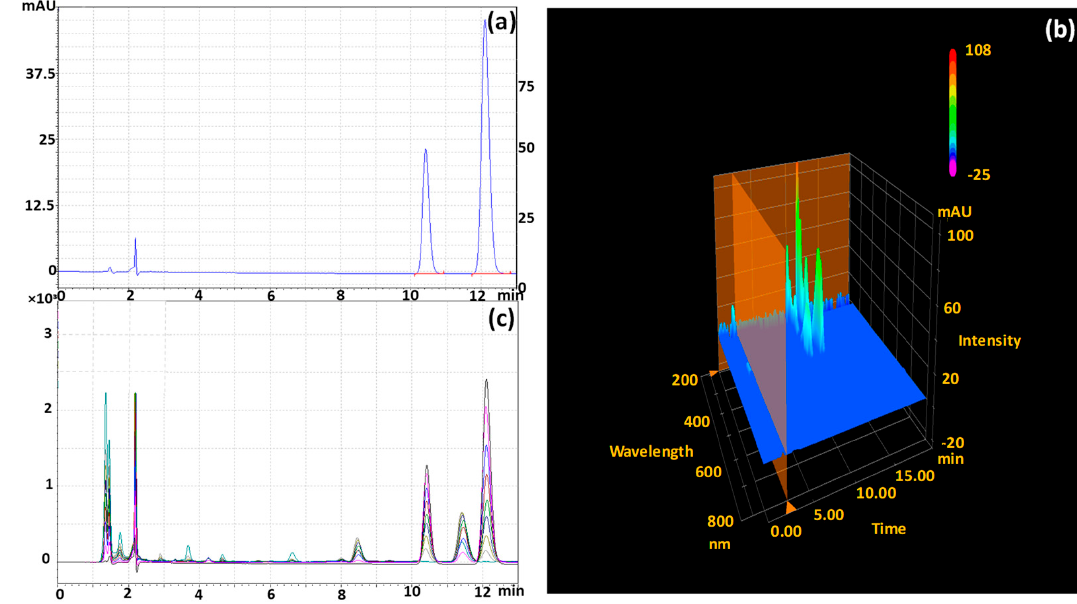
Figure 10. 2D HPLC chromatogram ( a ) and 3D HPLC chromatogram ( b ): some words have of QY mono-sulfonic acid isomers. HPLC chromatogram of photodegraded QY solution ( c ). ([QY] 0 = 20 ppm, Ag 3 PO 4 dose = 0.5 g·L − 1 and pH~7).